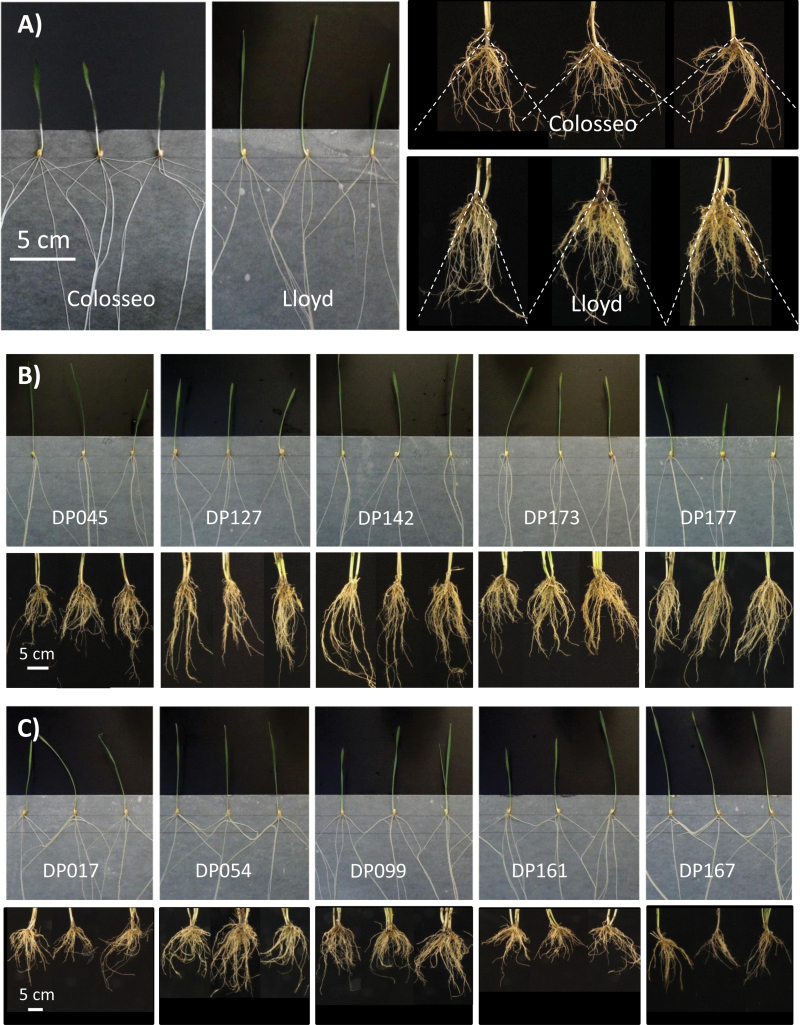
Root system architecture (RSA) of seedlings and field-grown plants of durum wheat parental lines and accessions from the elite Unibo-DP showing contrasting phenotypes for RSA features. (A) Comparison of RSA for the parental lines Colosseo (left) and Lloyd (right) at the adult stage in the field. Dotted lines originating at the crowns were traced to delimit 95% of the 2-D projected area of the root system (as suggested in the REST software manual). (B) Comparison of seedling and adult RGA for the five Unibo-DP accessions with the narrowest RGA according to seedling measurements. (C) Comparison of seedling and field RGA for the five Unibo-DP accessions with the widest RGA according to seedling measurements. (This figure is available in colour at JXB online.)